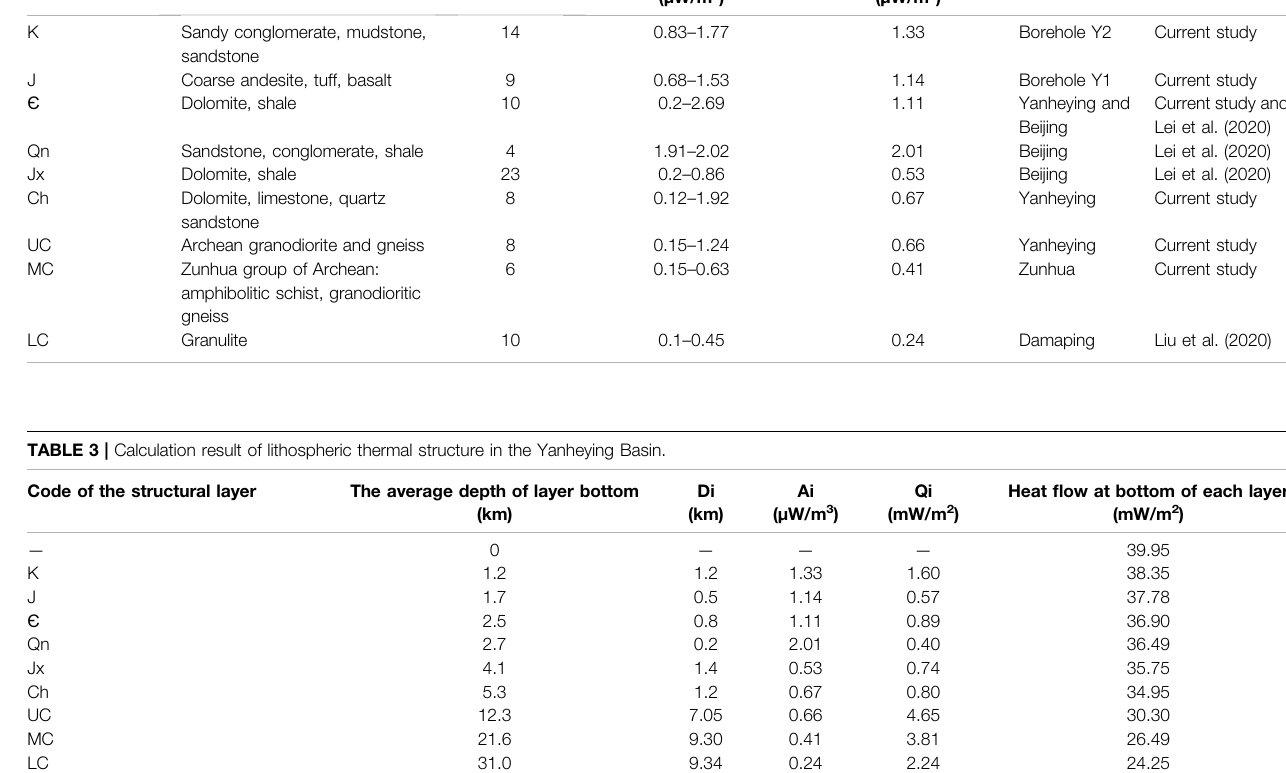
TABLE 2 | Radioactive heat production rates in the Yanheying Basin and surrounding pre-Cenozoic strata. Stratum code